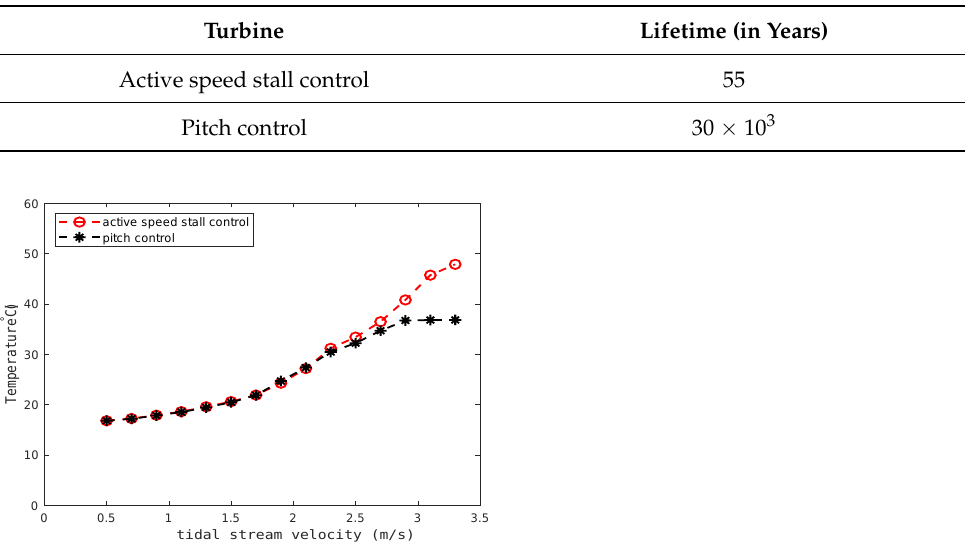
Figure 24. Mean junction temperatures of the diode (in the generator side converter) as a function of tidal stream velocity. Both turbines deliver the same power, albeit at different generator speeds. Below 2.5 m/s, active stall-controlled turbine operates at higher speed and thus has a lower temperature. Above 2.5 m/s, pitch-controlled turbine runs at higher speed. See Figure 6.